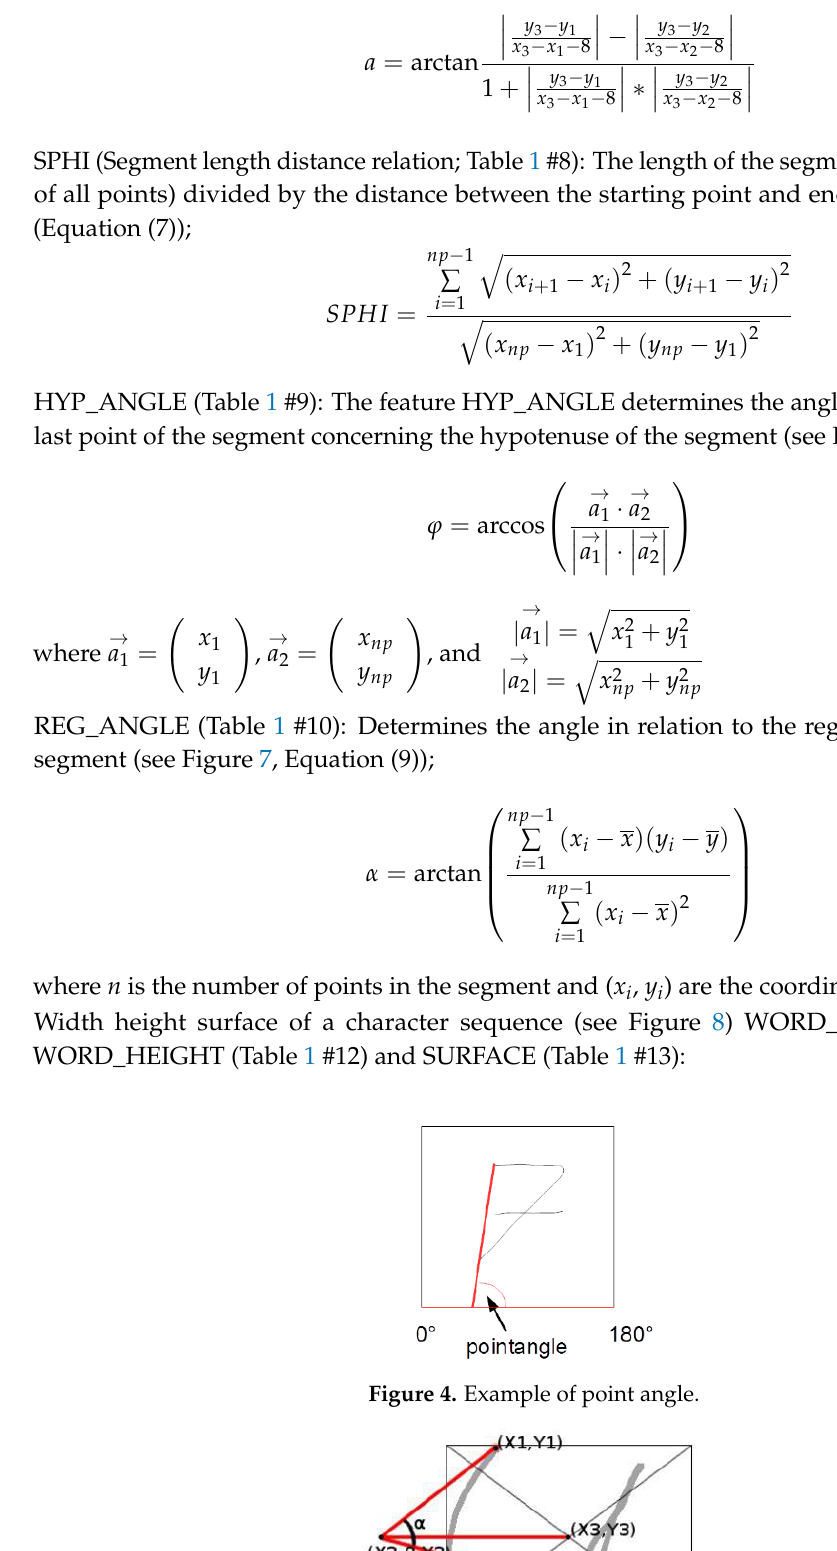
Figure 5. Example of horizontal point angle. 881 88 arctan